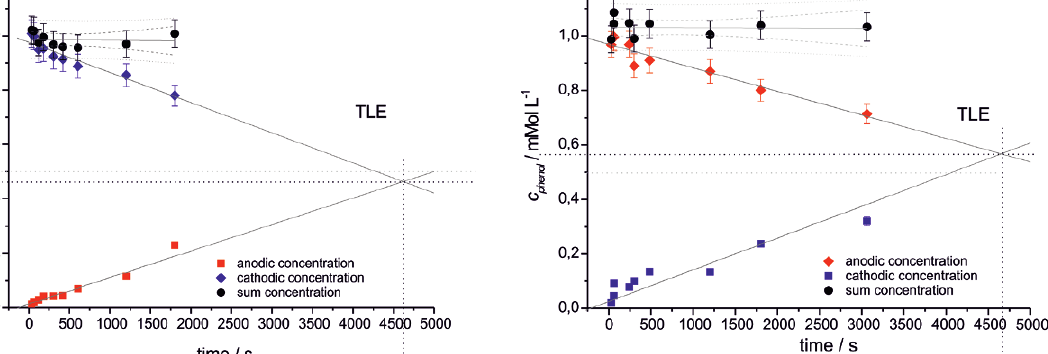
Figure 3. Exp. 1a: Transport of phenol from cathode to anodic beaker. The grey dashed line marks the theoretical mixture concentration (0.5 mmol L -1 ); the black dashed lines show concentration and time at the theoretical linear equilibrium (TLE). The concentration sum is evaluated with a linear fit including 95% confidence (dashed) and 95% prediction (dotted) intervals.